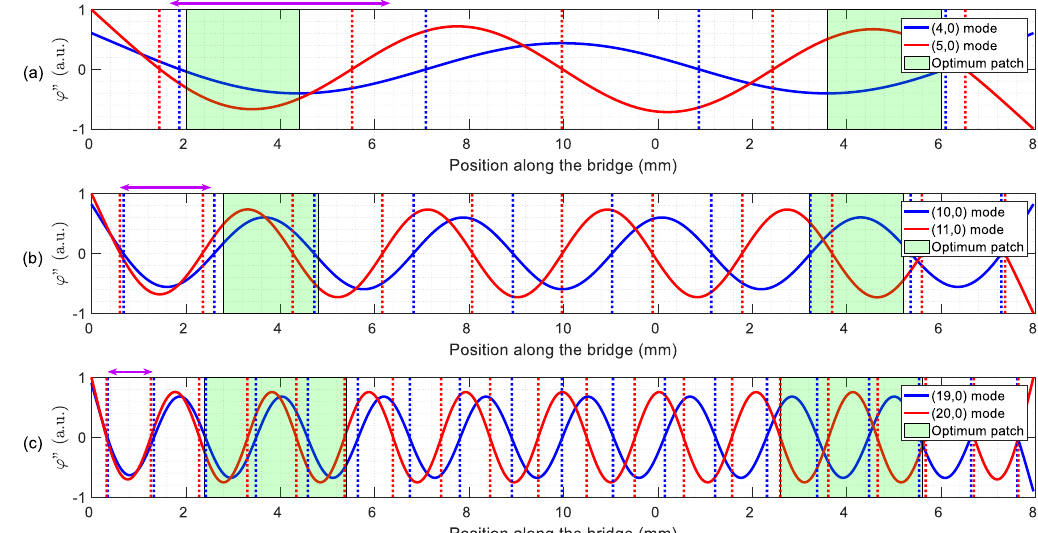
Figure 3. Second derivatives 𝜑′′ (solid lines) of the modes involved in the TW generation in the ( a ) low frequency (LF) range, ( b ) intermediate frequency (IF) range and ( c ) high frequency (HF) range. The positions of the zeros (dotted vertical lines) and optimum patch design (green area) are also indicated. A double-headed arrow indicates the patch based on the zeros of the second derivative.